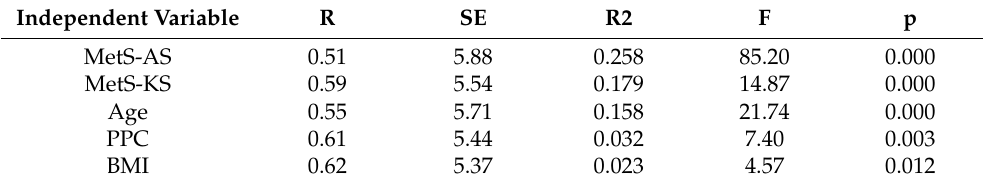
Table 5. Regression analysis of variables predicting MetS self-management behavior total scores (n =